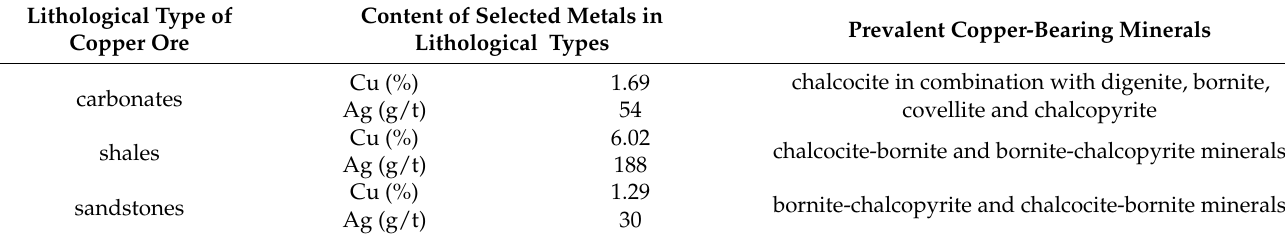
Table 1. Mineralogical composition of lithological types of Polish copper ores [6]. Lithological Type